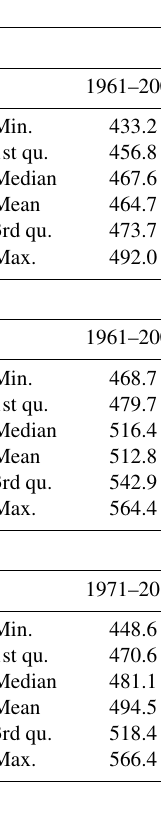
Table A5. Summary of the damage statistics visualized in Fig.